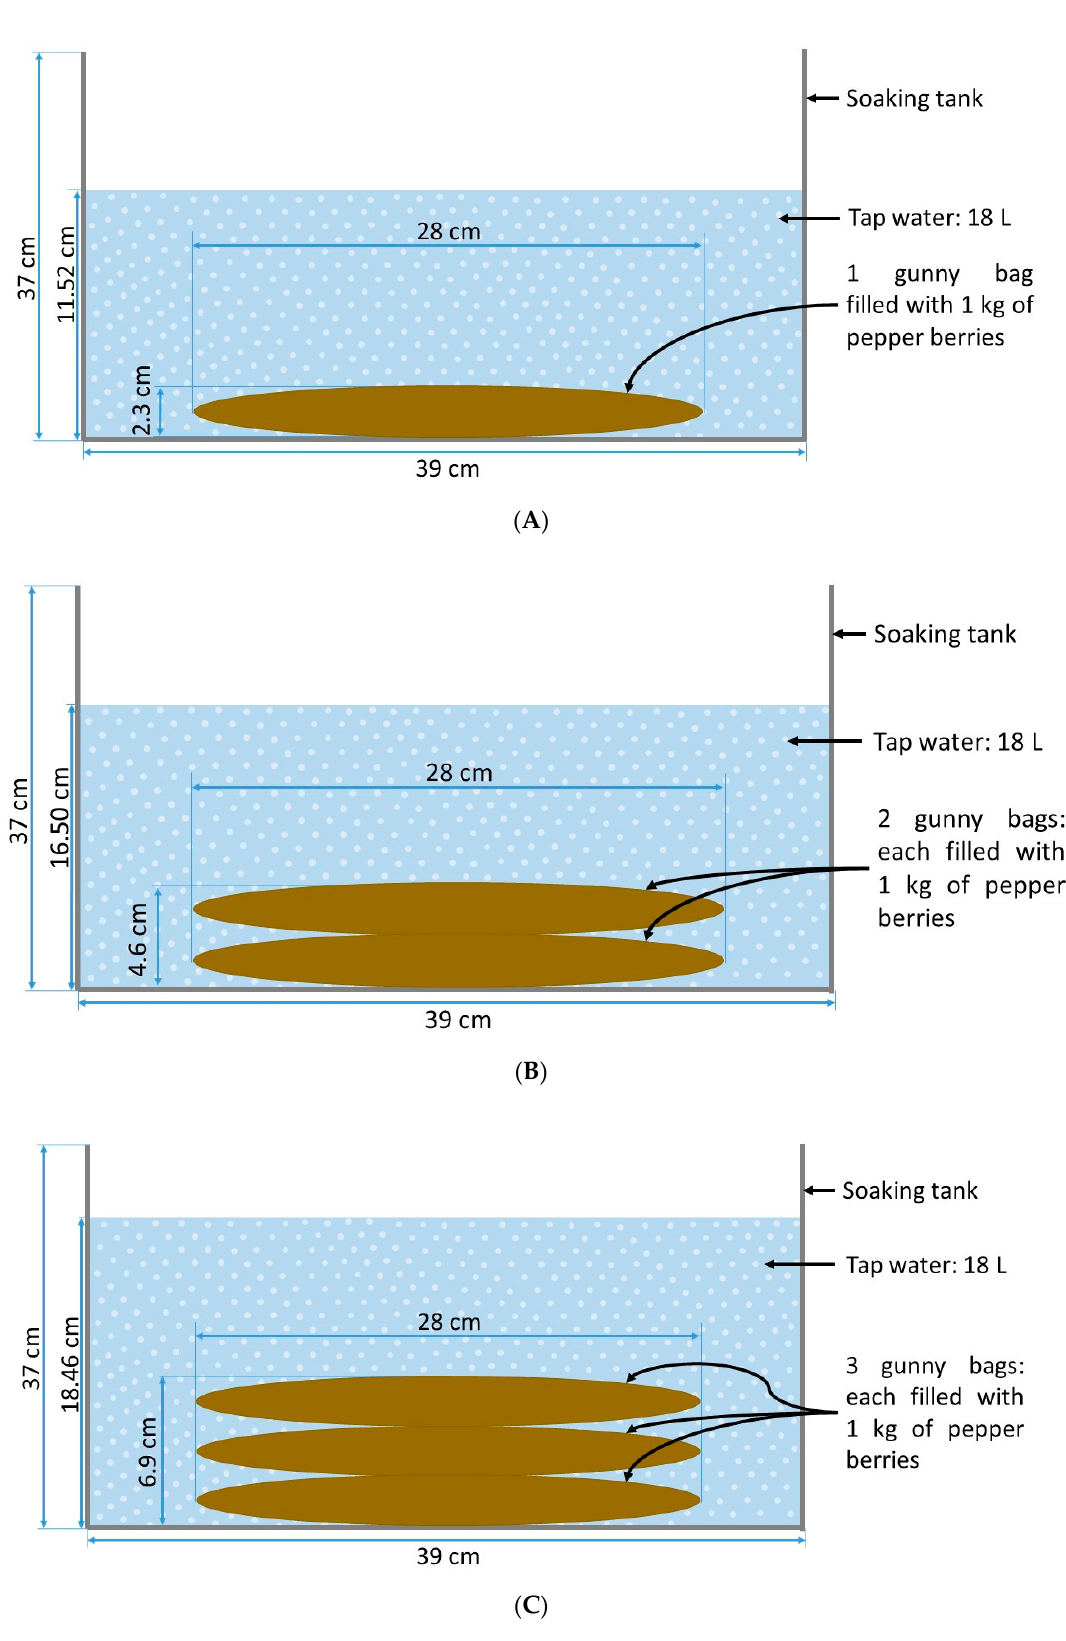
Figure 1. Drawing of tanks with different quantities of pepper berries soaked in water: ( A ) a tank of 1 gunny bag; ( B ) a tank of 2 gunny bags; ( C ) a tank of 3 gunny bags. Each tank was filled with 1kg of pepper berries, soaked in 18 L water.